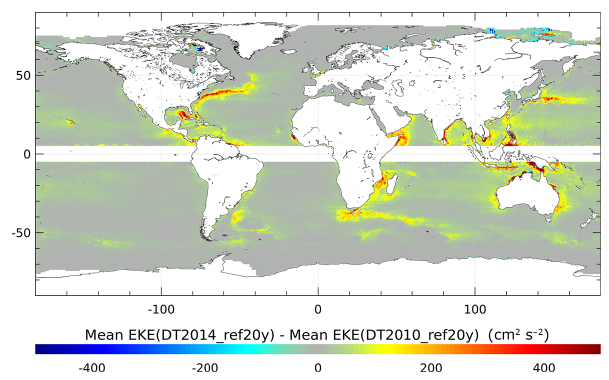
Figure 9. Difference of the mean EKE computed from DT2014 and DT2010 SLA over the [1993–2012] period. Gridded SLA merg- ing all the altimeters available are considered (i.e., “all-sat-merged” in DT2014; “UPD” in DT2010). DT2010 SLA was referenced to the 20-year altimeter reference period and interpolated onto a 1 / 4 ◦ × 1 / 4 ◦ Cartesian grid for comparison with DT2014. The same methodology (centered differences) was used for geostrophic cur- rent computations for DT2010 and DT2014.